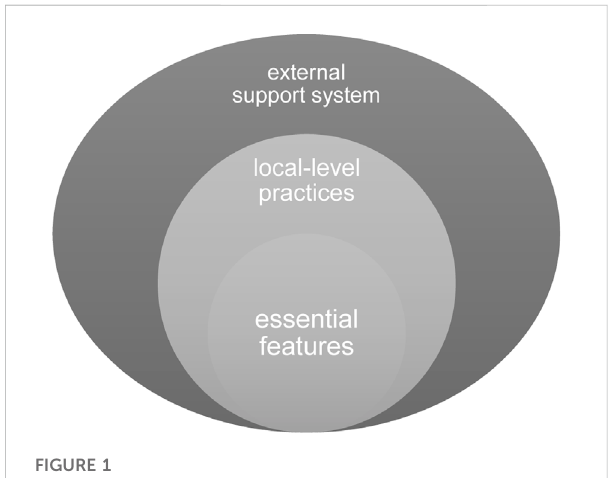
FIGURE 1 Three layers of adaptive